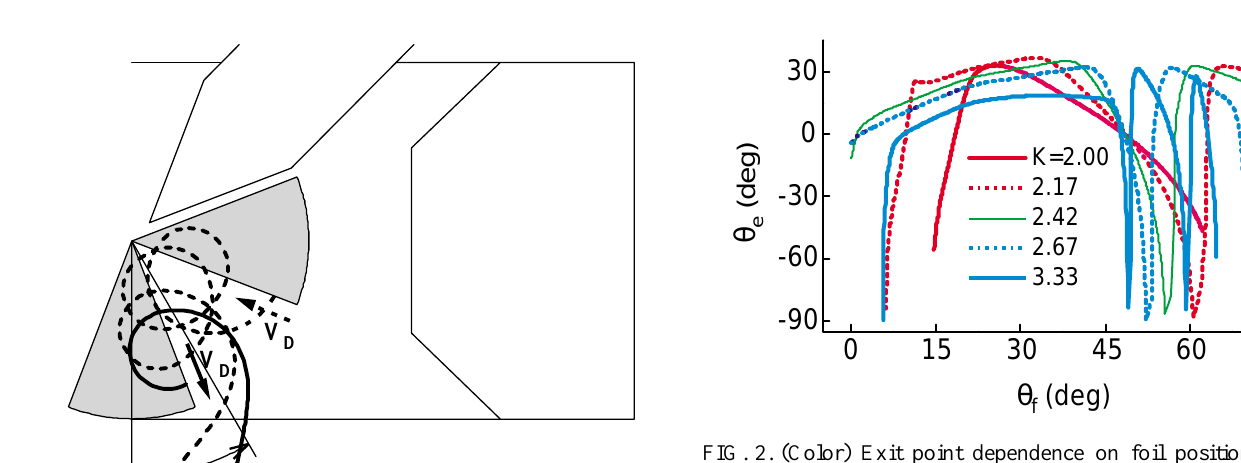
FIG. 2. (Color) Exit point dependence on foil position. The radius of the ion exit from the vacuum chamber of the VINCY cyclotron is 1.6 m. The exit point is defined by its azimuthal coordinate u e along the exit radius. Foil position is also defined by its azimuthal coordinate u f , but along the equilibrium orbit of an ion. The u e dependence on u f is strongly influenced by the K parameter. The “hops” that u e exhibits during u f increase correspond consequently to a single, double, and triple loop trajectory of a stripped ion (see Fig. 3). If the loop radius is small, i.e., if K is large, the u e (cid:4) u f (cid:5) curve exhibits three hops, and an ion trajectory can have as many as three loops after the foil (see K (cid:1) 3.33 and 2.67). The larger the loop radius, the smaller the maximum number of loops. The transition to a different number of loops in a trajectory is caused by inward or outward drift. These transitions, for K (cid:1) 3.33 , are illustrated and explained in Fig. 3. Note the width Du f , and the maximum u e , of the hops corresponding to a one loop extraction. For ion energies lower than the largest, the width and the maximum of the hop is smaller. For different cyclotrons, the curve parameter K should be replaced with K (cid:1) V , where V is the angular width of the valley. For the VINCY cyclotron, V (cid:1) 48 ±